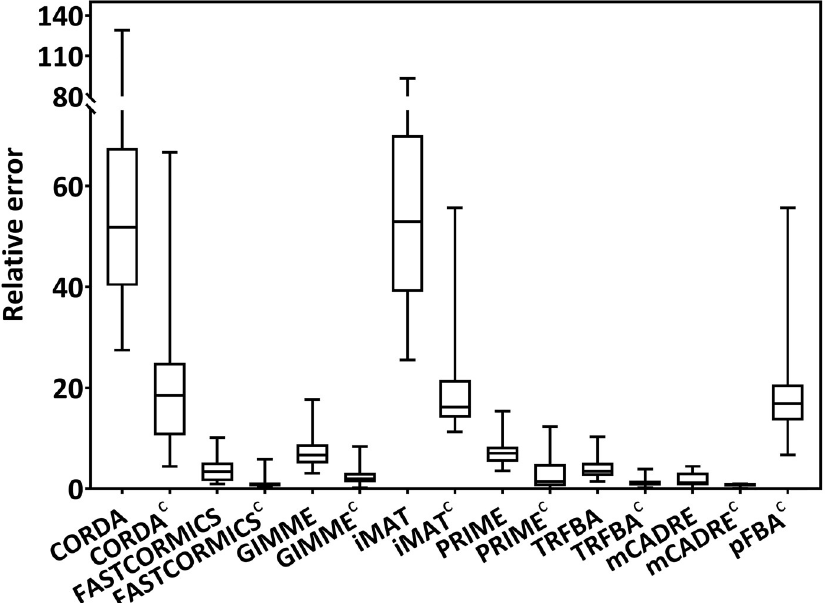
Fig 1. Growth rate prediction. Distribution of relative error for prediction of growth rates for all algorithms using both general and cell-specific medium (designated by the superscript c). Each box-plot shows the distribution of error across all cell lines in NCI-60 panel. Only algorithms capable of predicting non-zero growth rates were depicted. Relative error was calculated according to the (Eq 2).